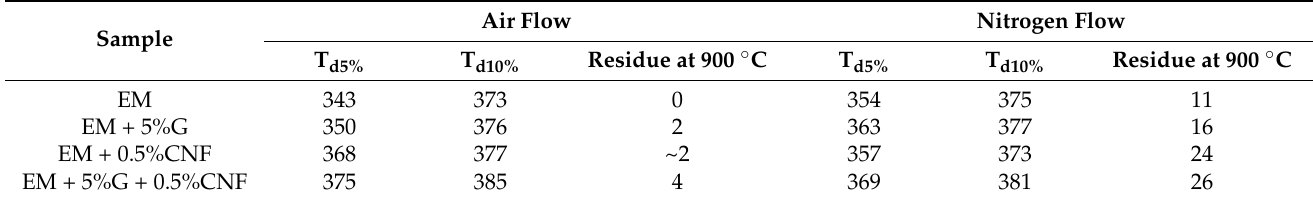
Table 3. Values of thermal degradation temperatures T d5% and T d10% , and the residue at 900 ◦ C.